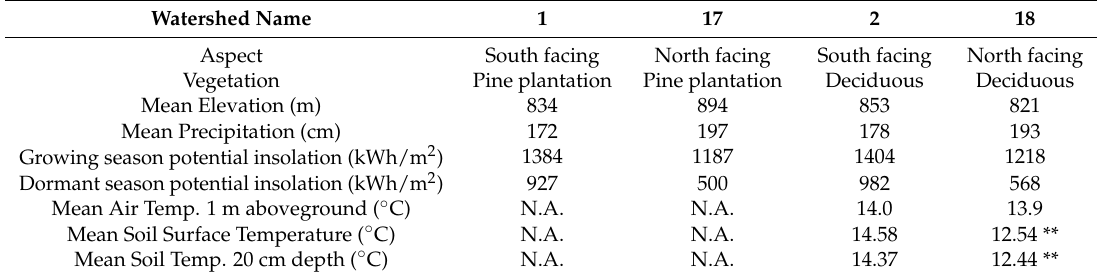
Table 1. Characteristics of the four paired watersheds used in this